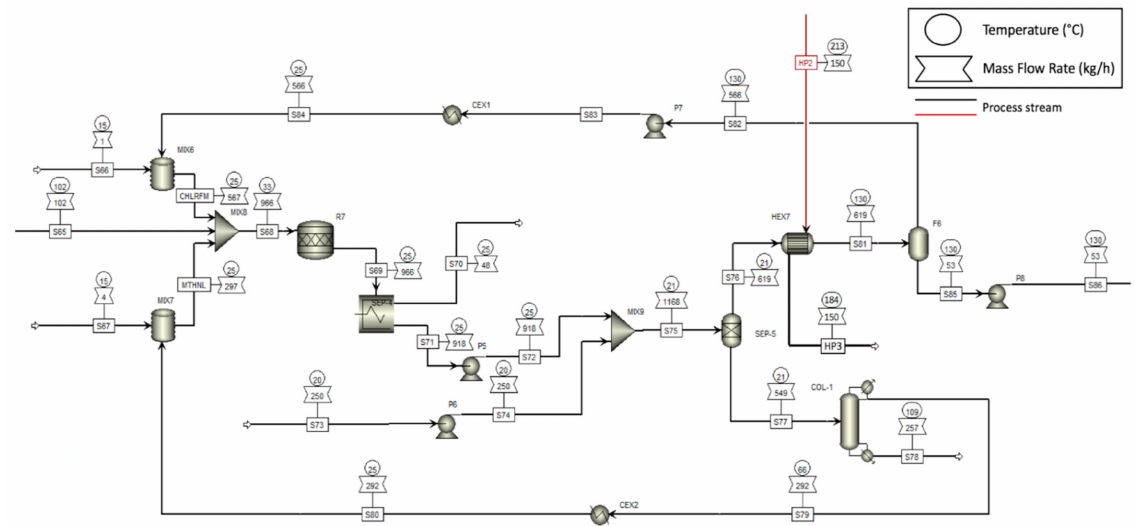
Figure 4. Flowsheet of lipid extraction with chloroform–methanol mixture as simulated using Aspen